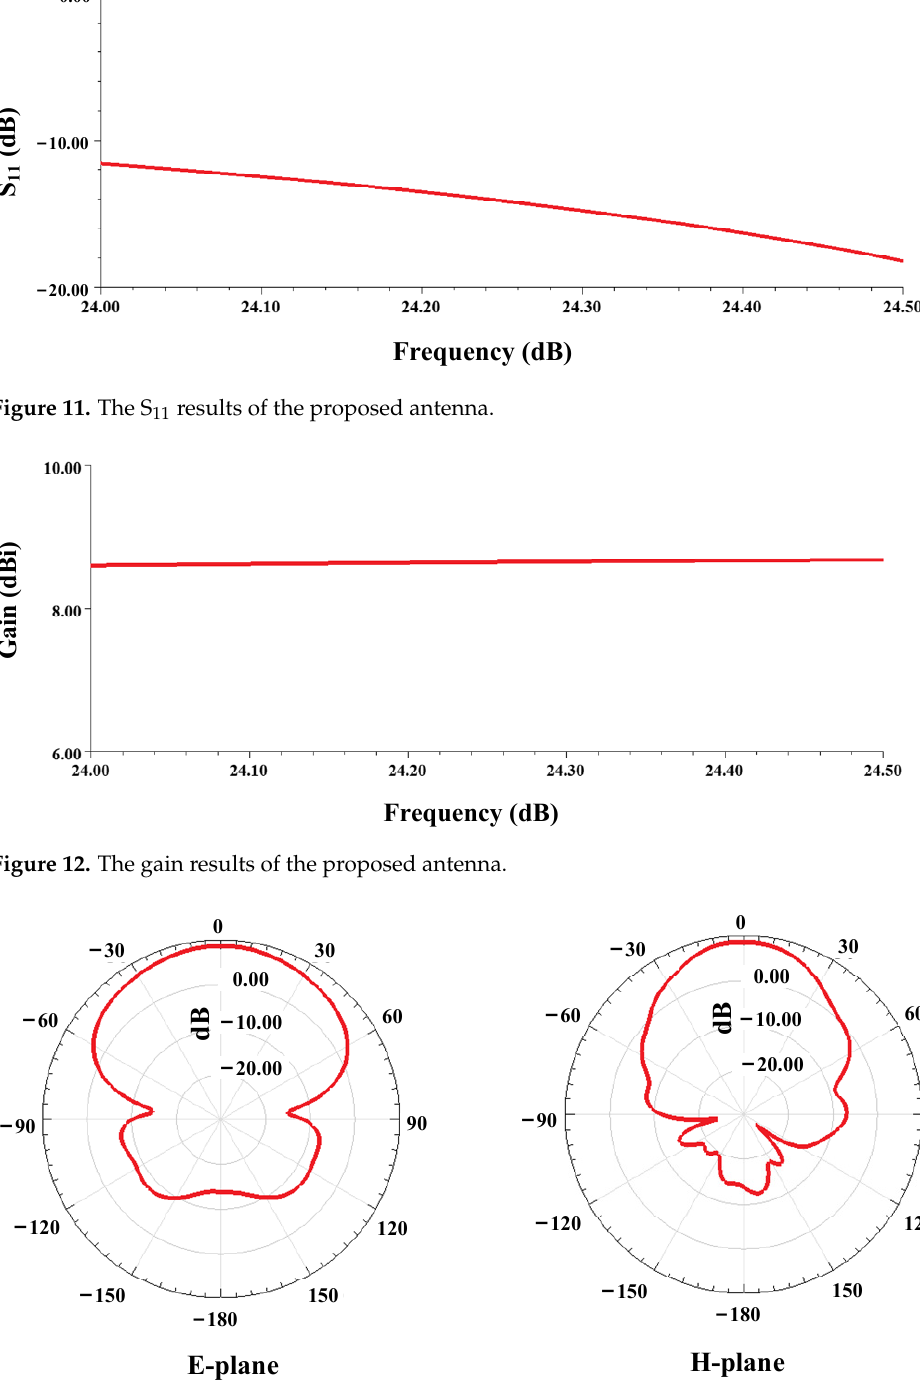
Figure 13. The patterns at 24.25 GHz of the proposed antenna.